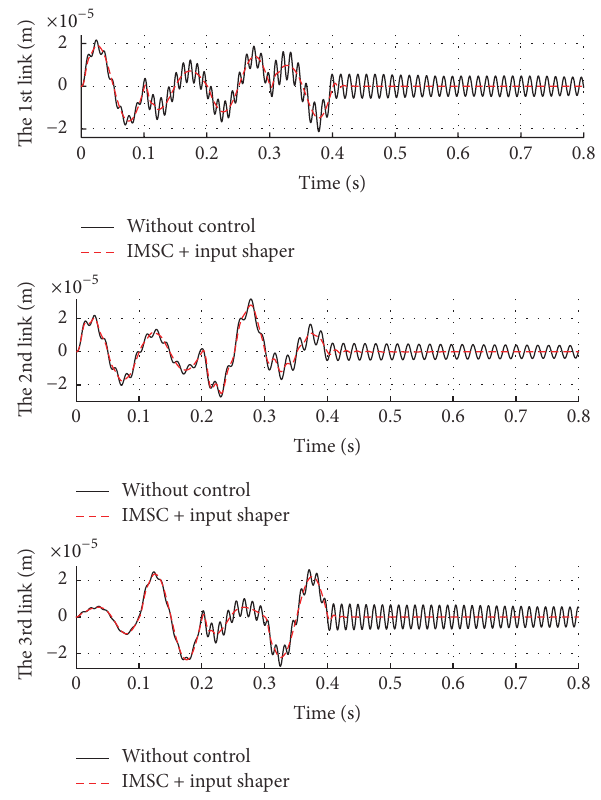
Figure 3: The vibration response at three-quarters of the three flexible